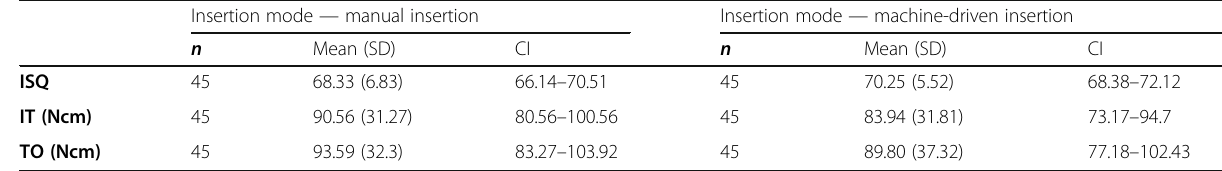
Table 2 Comparison of manual and machine-driven insertion mode Insertion mode — manual insertion Insertion mode — machine-driven insertion